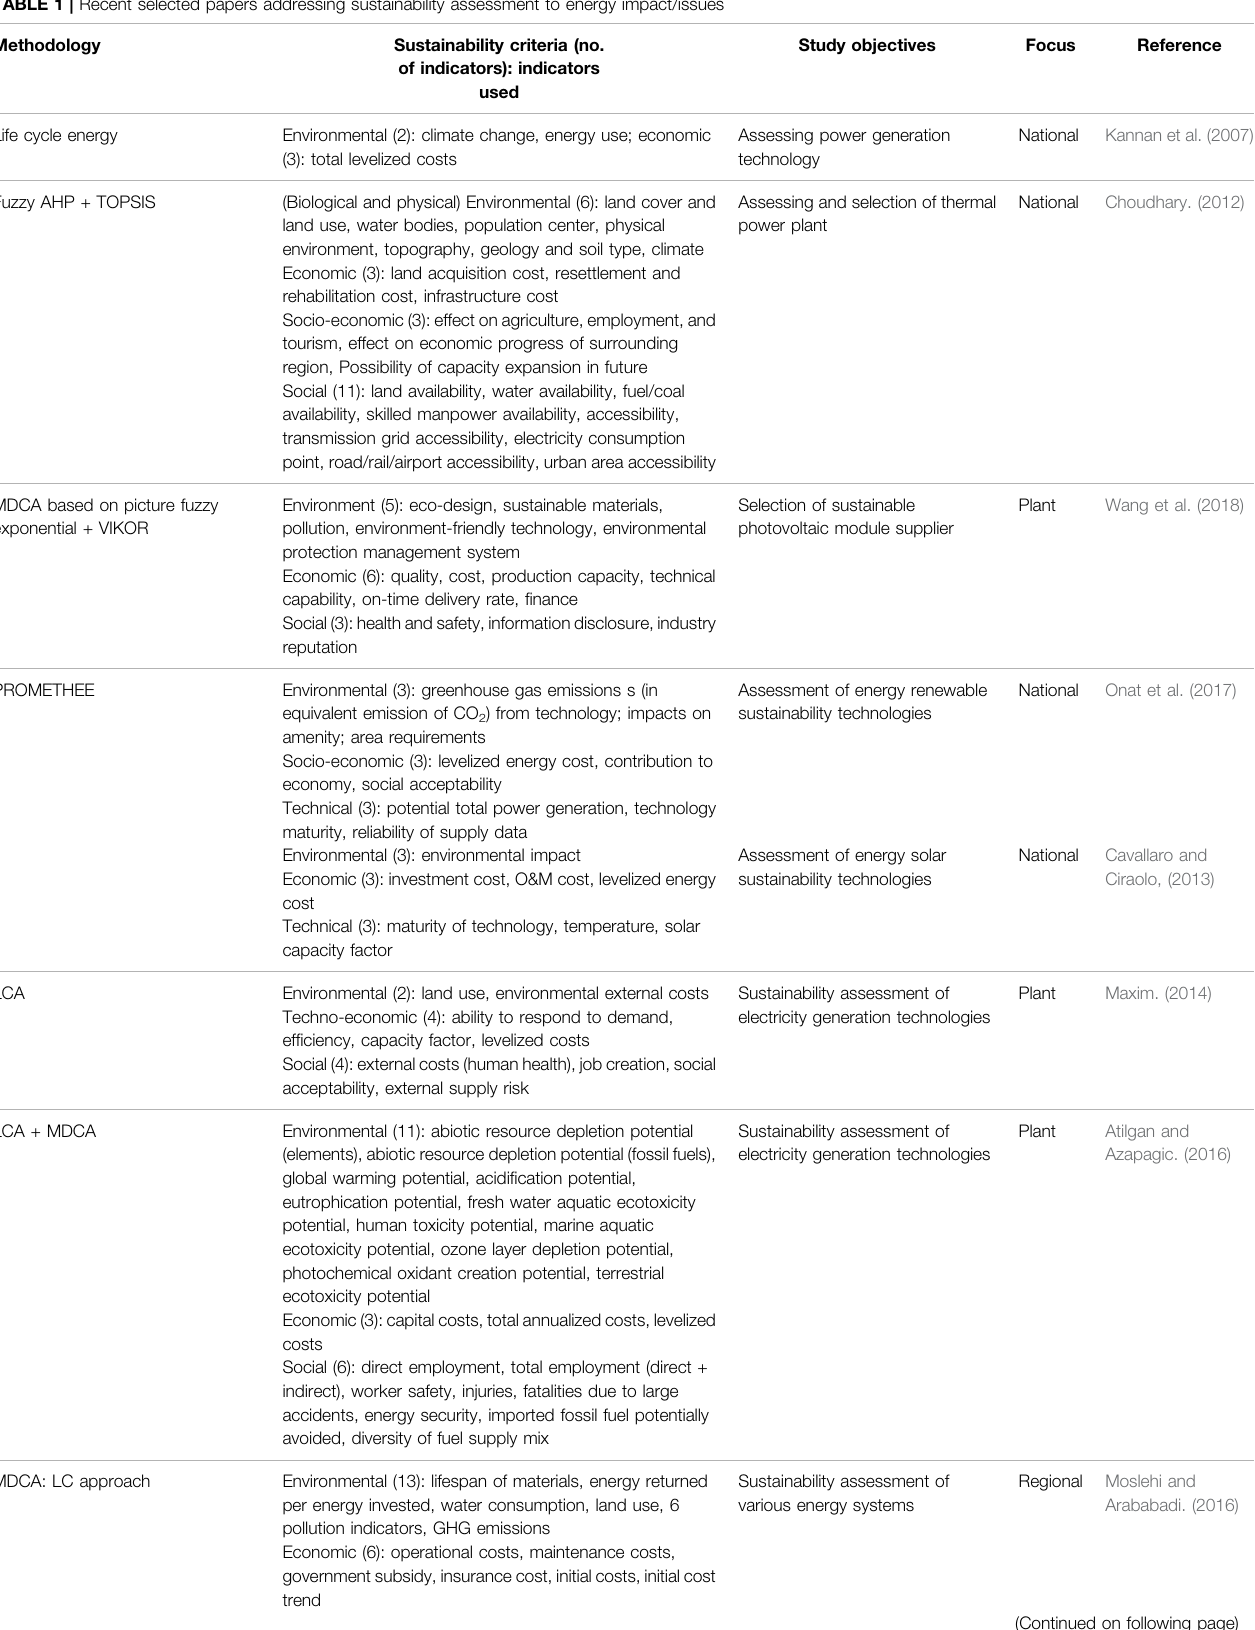
TABLE 1 | Recent selected papers addressing sustainability assessment to energy impact/issues